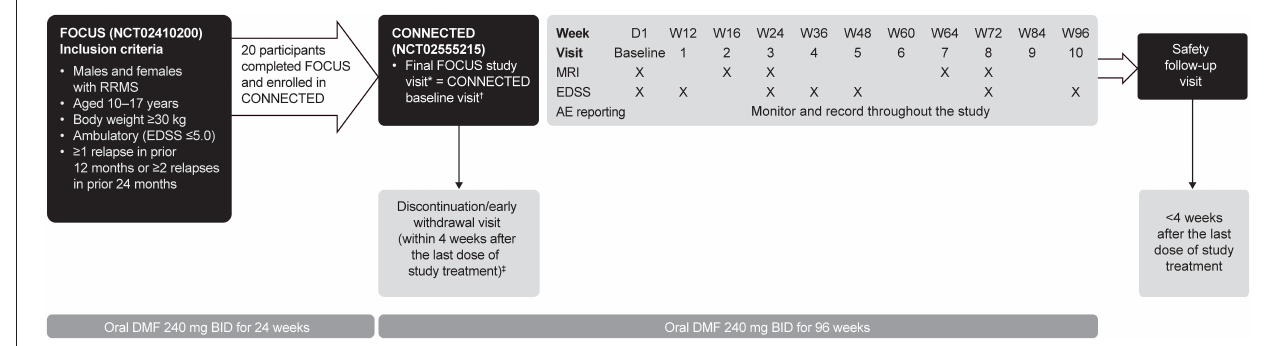
FIGURE 1 | CONNECTED study design. AE, adverse event; BID, twice daily; D, day; DMF, delayed-release dimethyl fumarate; EDSS, Expanded Disability Status Scale; MRI, magnetic resonance imaging; RRMS, relapsing-remitting multiple sclerosis; W, week. *Eligibility for CONNECTED was determined at the final study visit in FOCUS or within 4 weeks before CONNECTED study entry. † Within 4 weeks of the final study visit for FOCUS, if the two visits could not have been held at the same time. ‡ Participants who discontinued treatment early could remain in the study and continue protocol-required tests and assessments, and those who withdrew prematurely were encouraged to complete the safety follow-up